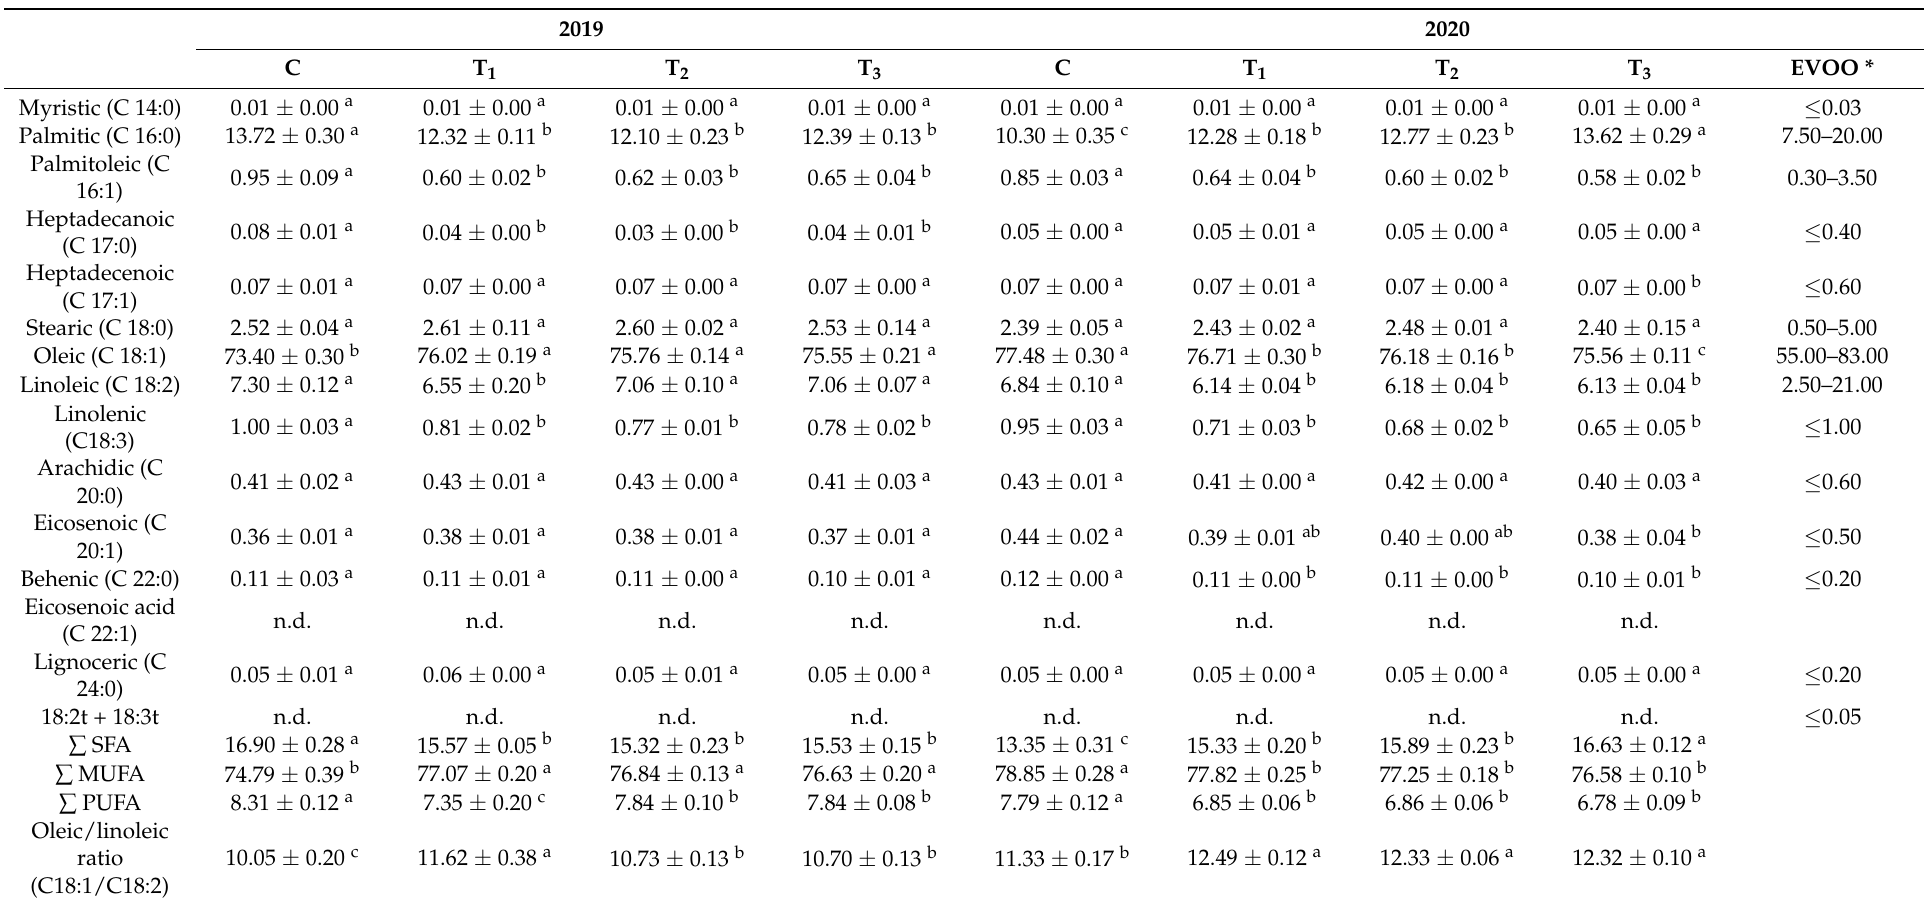
Table 5. Fatty acid profile (%) of virgin olive oils from Coratina cv. olive trees grown under different watering regimes during two crop seasons (2019 and